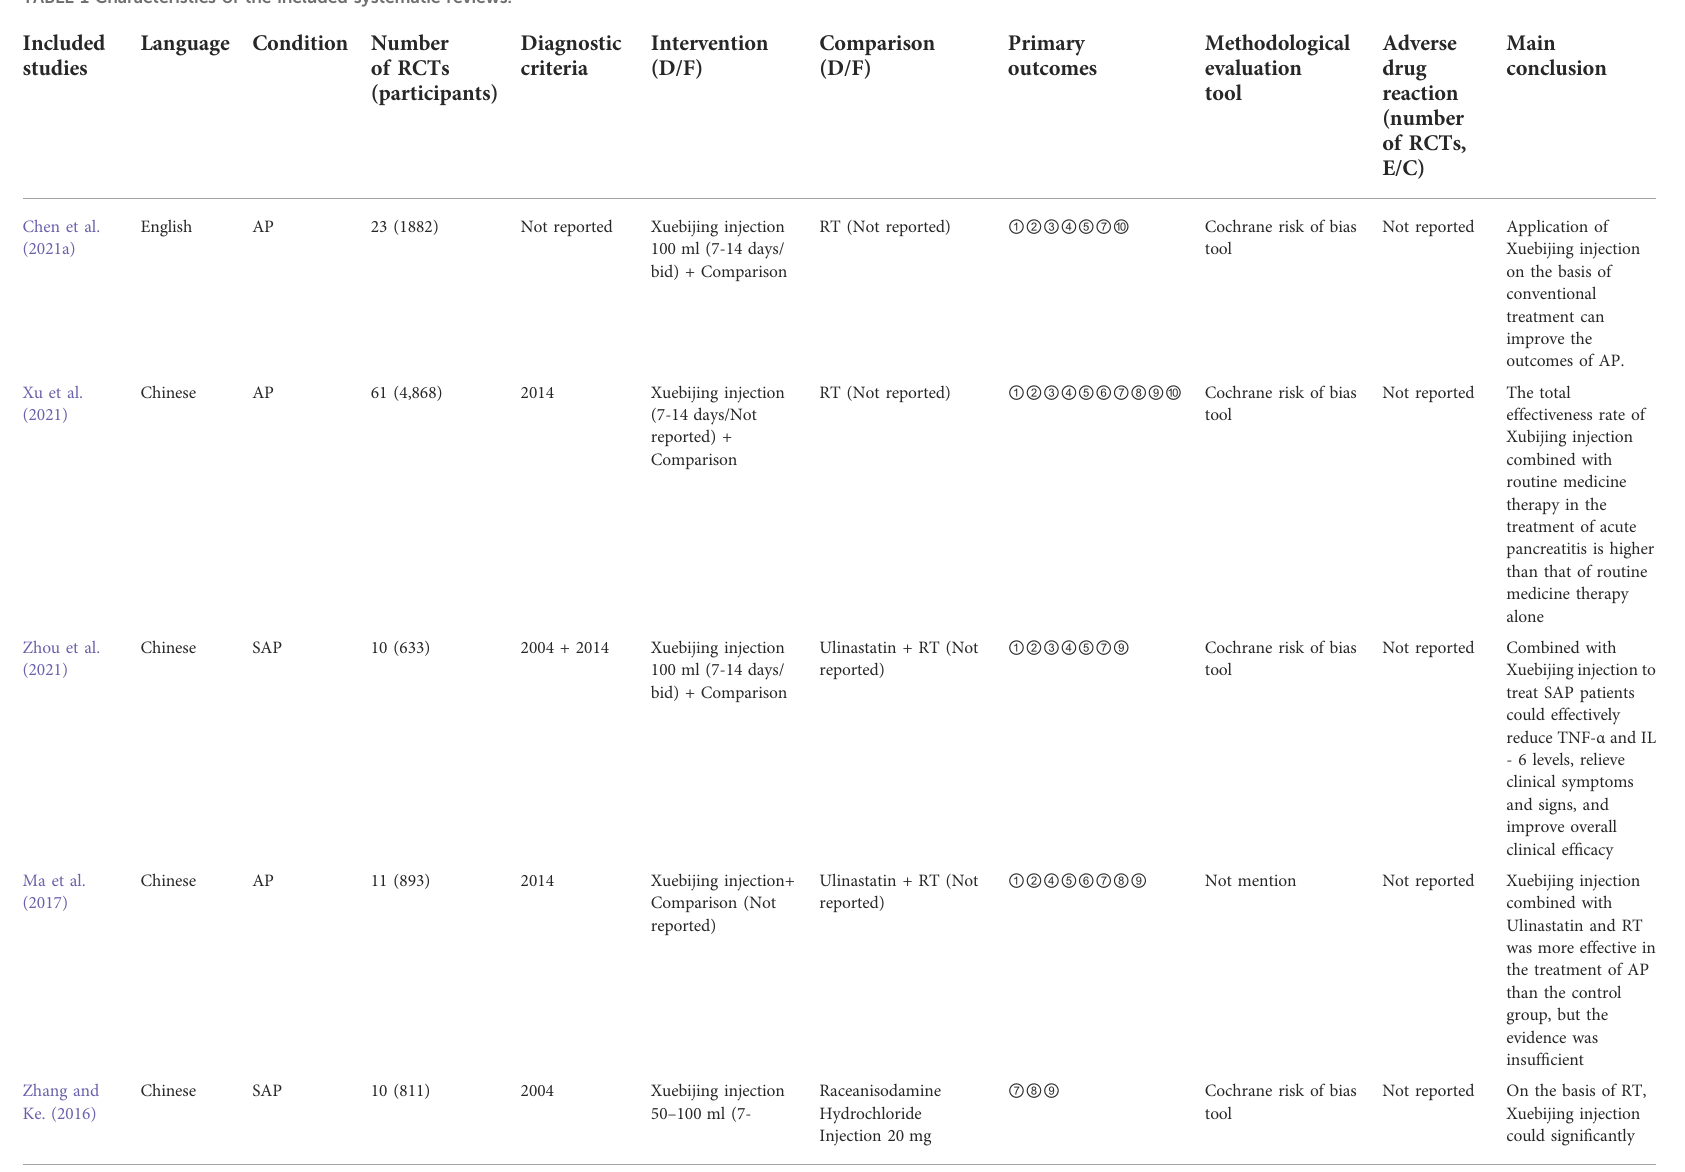
TABLE 1 Characteristics of the included systematic